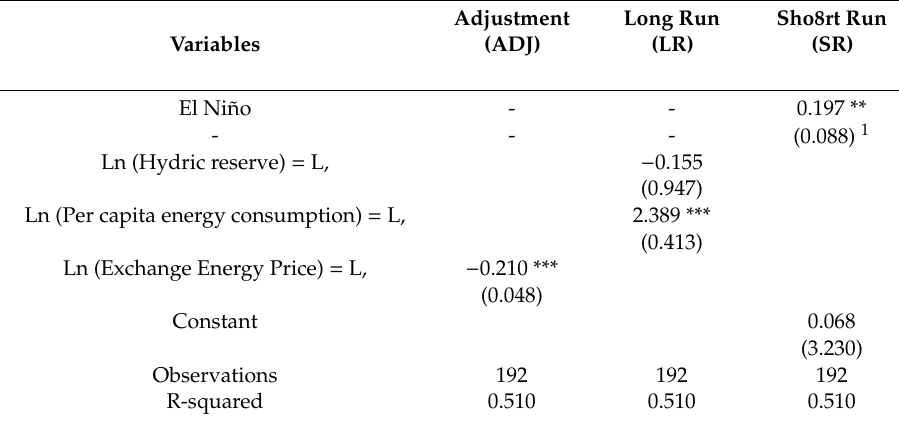
Table 3. Error correction